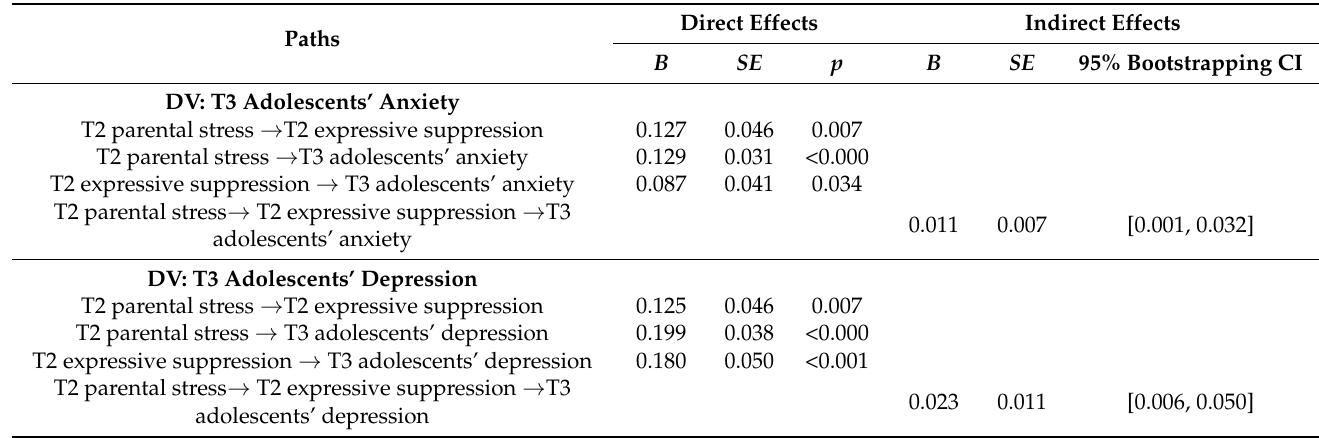
Table 4. The specific direct and indirect effects for each pathway in the models ( n = 288).